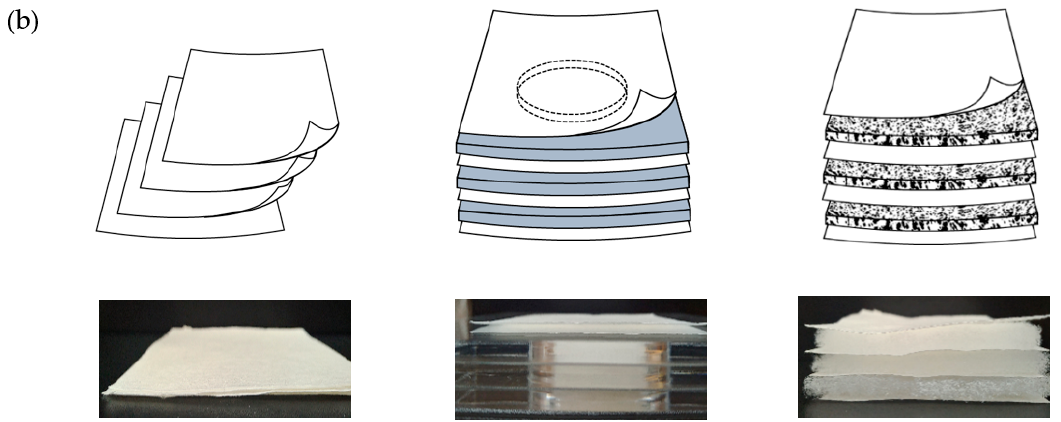
Figure 2. Experimental set-up for layer construction. ( a ) 2-Layer construction, ( b ) 4-Layer construction.